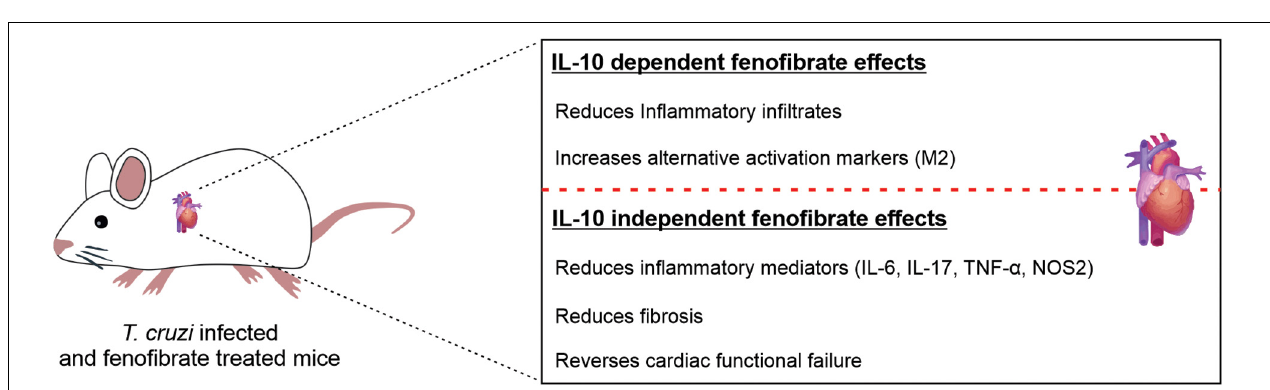
FIGURE 10 | Expression of ROR γ t and FOXP3 in IL-10KO and WT mice. The level of transcription of ROR γ t (A) and FOXP3 (B) mRNA was determined by qRT-PCR in heart homogenates from uninfected, T. cruzi- infected, and T. cruzi- infected fenofibrate-treated WT and IL-10 KO mice. Differences between groups were analyzed by ANOVA (mean ± SEM) followed by Tukey post hoc test. Differences were considered significant when p < 0.05. 7 mice per group, 3 replicate experiments. ** p < 0.01 and *** p < 0.001.